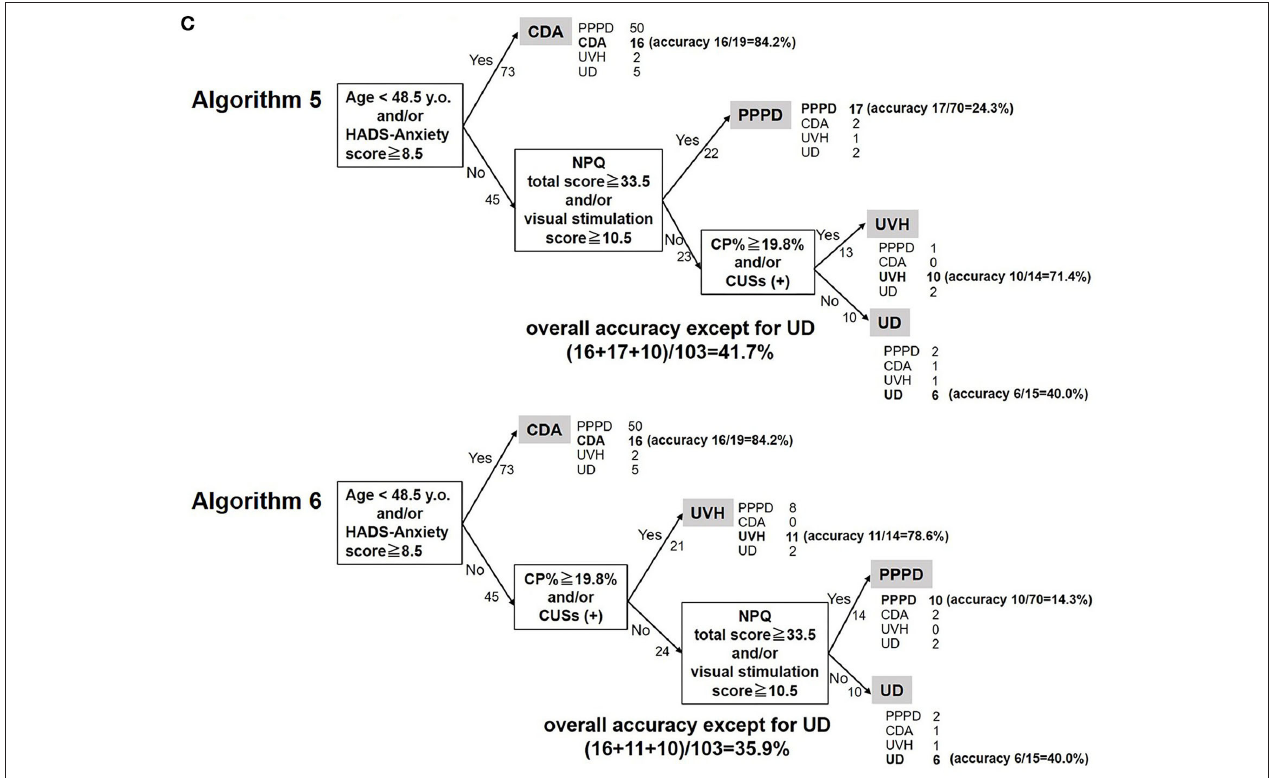
FIGURE 3 | Diagnostic algorithms for chronic vestibular syndromes. (A) Algorithms diagnosing PPPD first. The overall accuracies for Algorithms 1 and 2 were 72.8 and 71.8%, respectively. (B) Algorithms diagnosing UVH first. The overall accuracies for Algorithms 3 and 4 were 57.3 and 35.0%, respectively. (C) Algorithms diagnosing CDA first. The overall accuracies for Algorithms 5 and 6 were 41.7 and 35.9%, respectively. NPQ, Niigata PPPD questionnaire; CP%, percentage of canal paresis; HADS, hospital anxiety and depression scale; PPPD, persistent postural-perceptual dizziness; CDA, chronic dizziness due to anxiety; UVH, unilateral vestibular hypofunction; UD, undifferentiated dizziness; CUS, catch-up